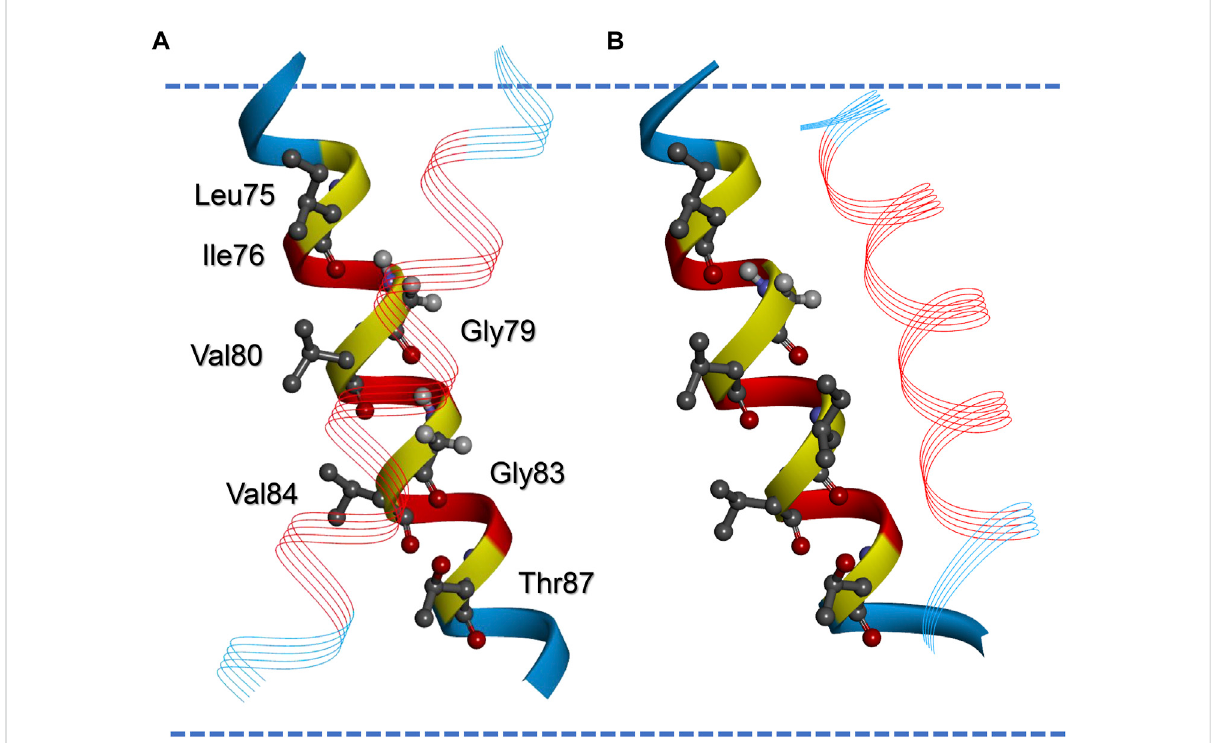
FIGURE 3 Modelled structures of the wt and G83I-mutated GpA13 TM helix dimer. Model of the wt (A) and the G83I-mutated GpA TM helix dimer (B) calculated byTMDOCK(LomizeandPogozheva,2017).The helicesinthebackarematchedinorientationto allowcomparisonoftheposition ofthe second helix in the dimer (line ribbon presentation). Residues originating from the original GpA TM sequence are shown in red, the fl anking amino acids, which were added by the expression plasmid but also contribute to TM helix formation, are shown blue. Amino acids of the GpA LIxxGVxxGVxxT dimerization motif are highlighted. Note that G83 is replaced by an Ile in (B) . The margins of the hydrophobic part of the membrane as calculated by the software implemented in PP3 (Lomize et al., 2022) are indicated by blue broken lines. Note that according to this model the not Leu-prolonged dimers experience negative hydrophobic mismatch, as discussed in the